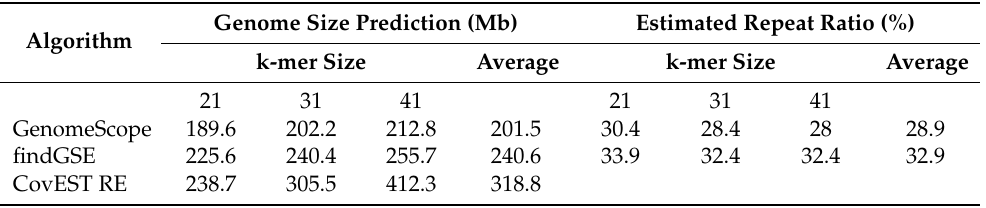
Table 1. Summary of T. freemani genome size and repeat ratio estimation. Three different programs (GenomeScope, findGSE, CovEST RE) were used with varying k-mer